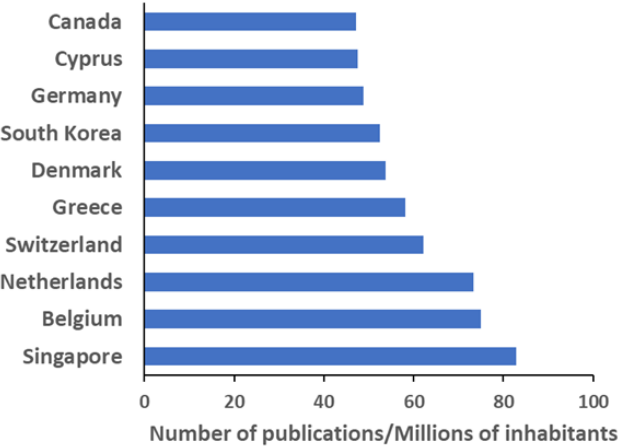
Figure 6. Top 10 countries in normalized scientific production, as number of publications per million of inhabitants.